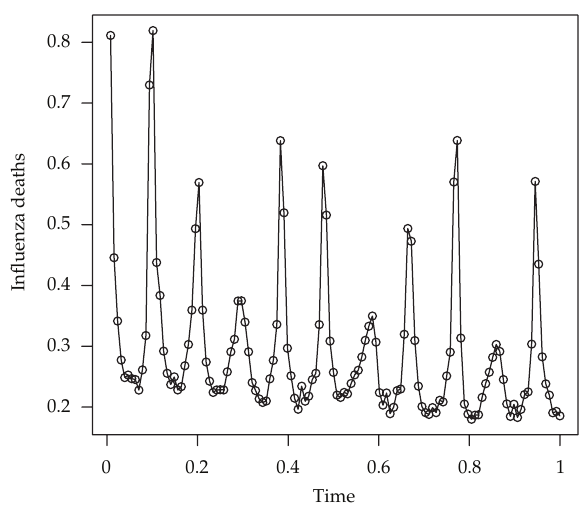
Figure 2: U.S. monthly pneumonia and influenza deaths per 10,000 over 11 years from 1968 to 1978.